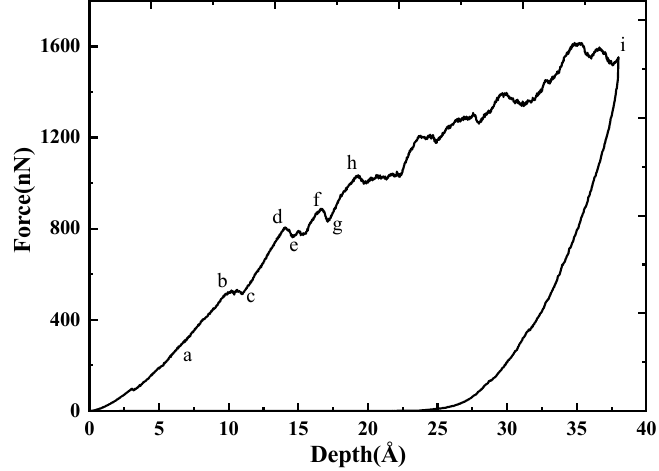
Figure 2. P - h curve of indentation on GaN (001) plane.